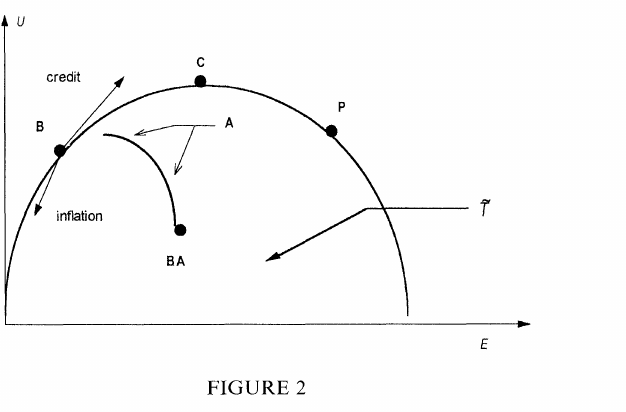
ciency. Being in effective equilibrium,